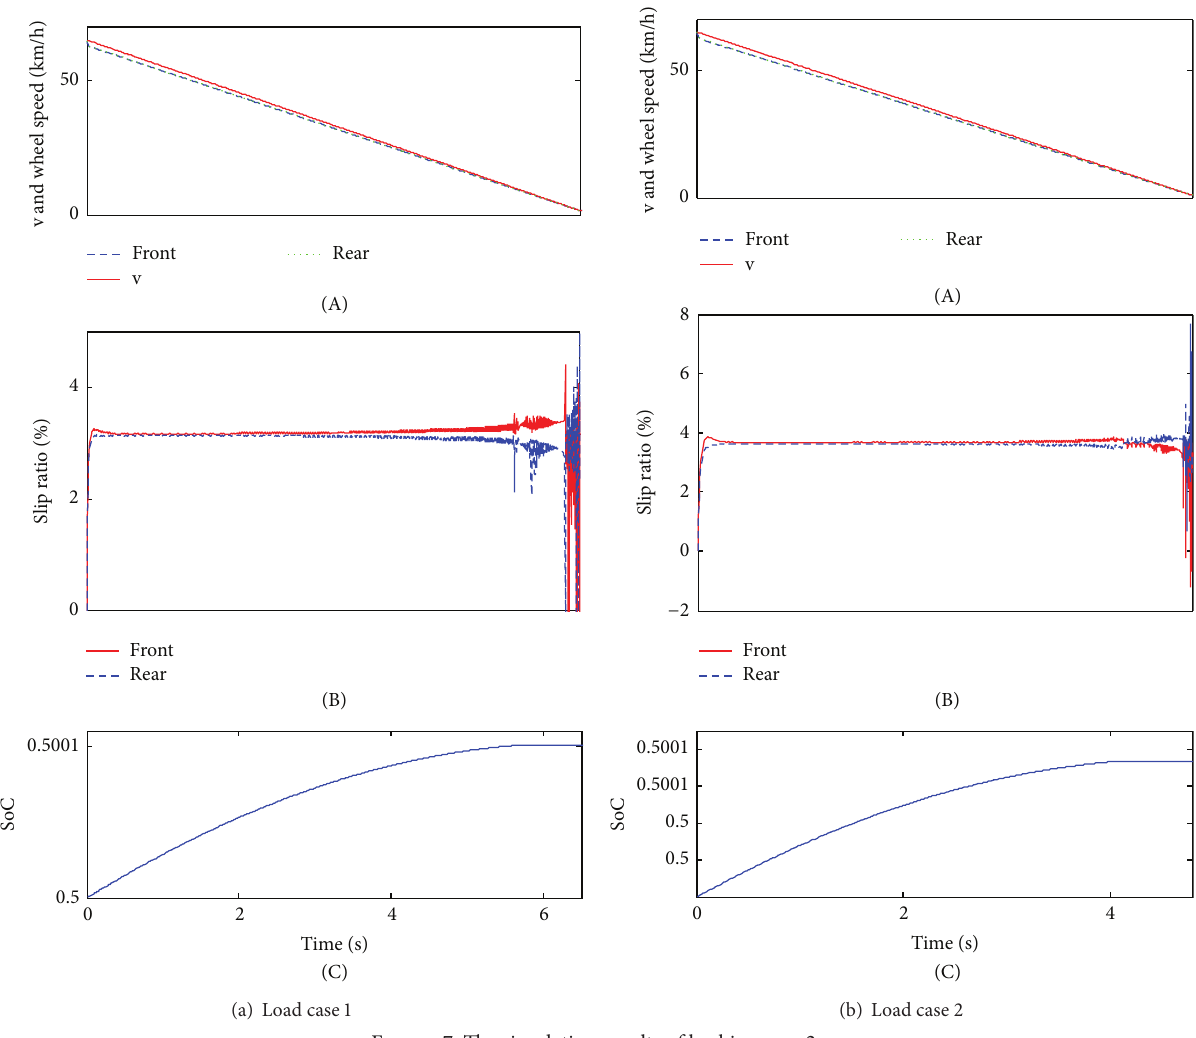
Figure 7: The simulation results of braking case 2.